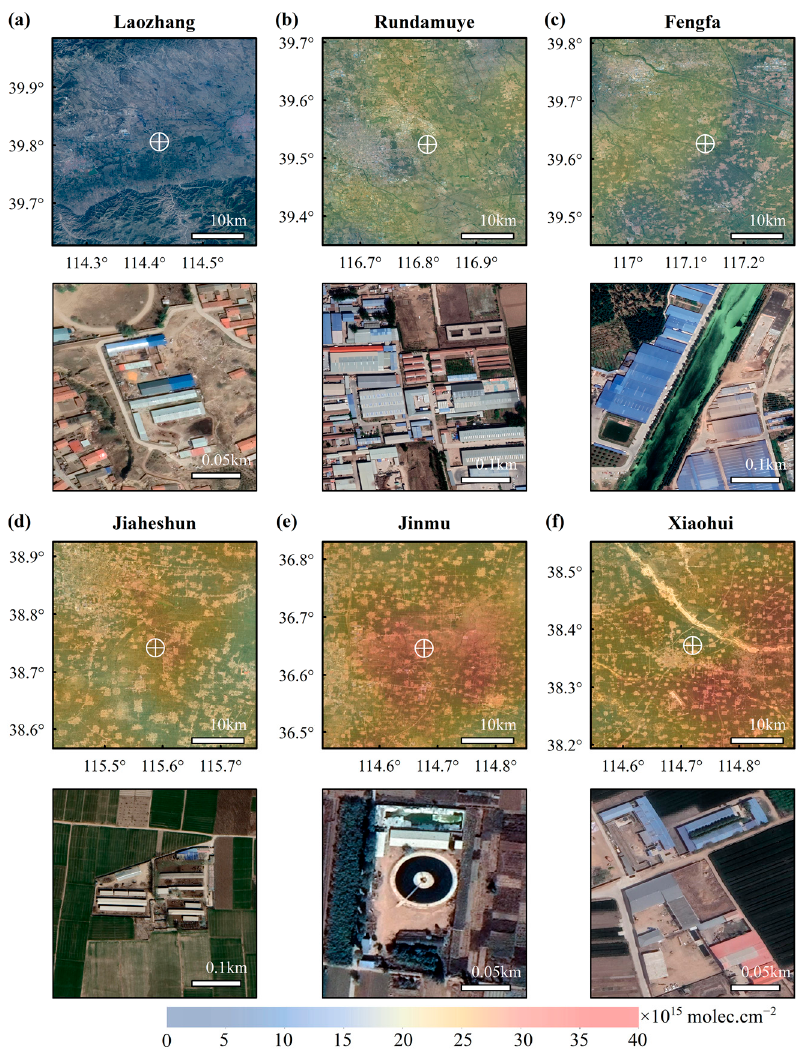
Figure 2. Examples of some livestock point sources. ( a – f ): the feedlots of Laozhang, Rundamuye, Fengfa, Jiaheshun, Jinmu and Xiaohui.